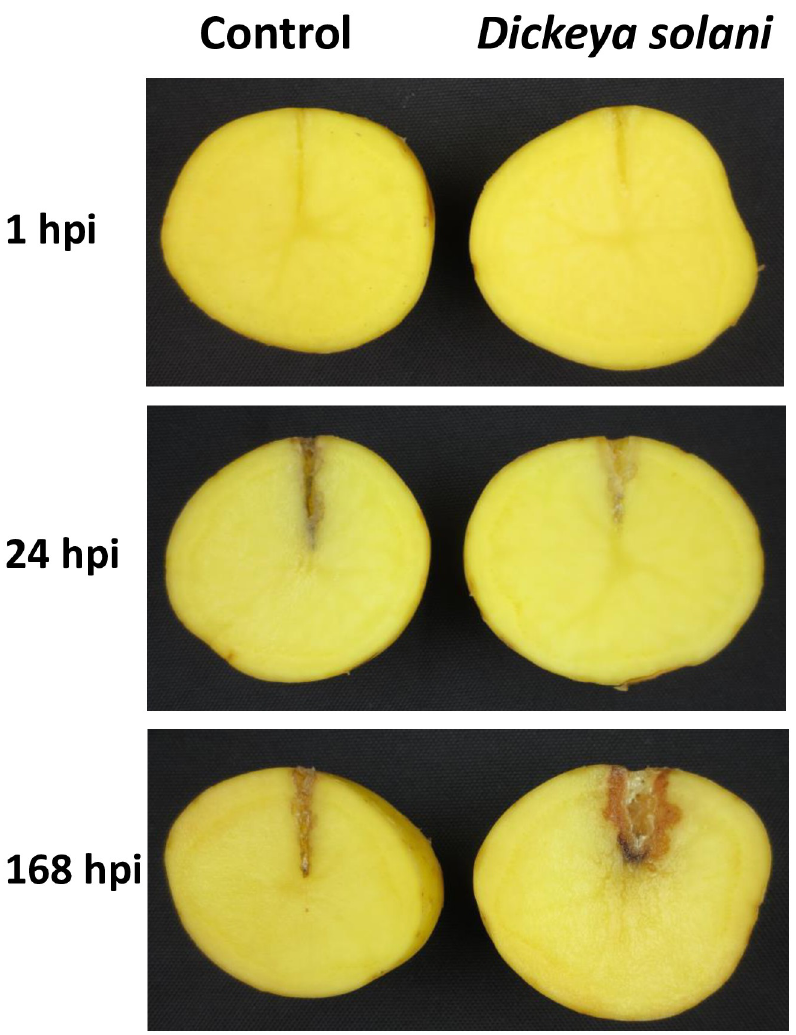
Fig 1. Symptoms caused by Dickeya solani infection in potato tubers 1, 24 and 168 hours postinoculation (hpi). Each tuber was inoculated with suspension containing 2.5 × 10 7 CFU of Dickeya solani in 50 μ l of sterile water. Sterile water was used as a negative